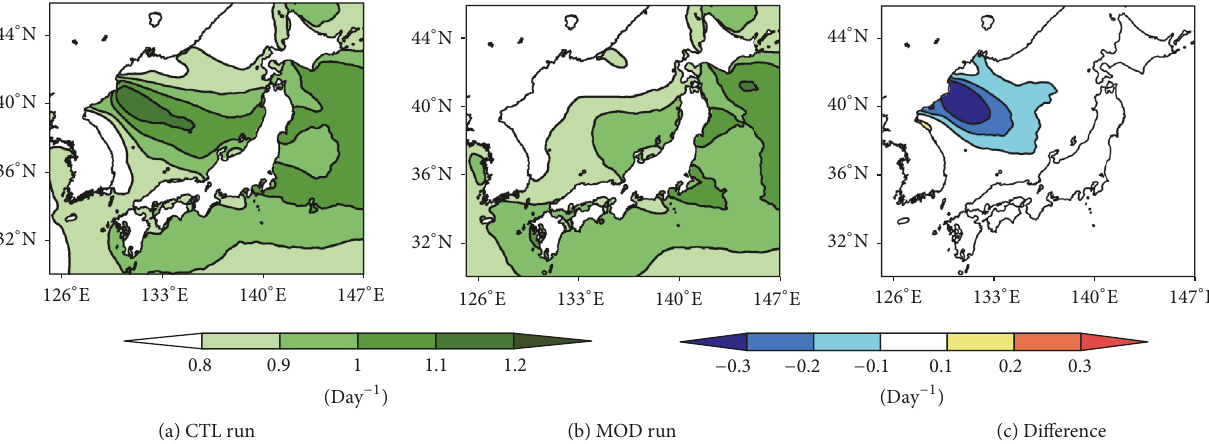
Figure 3: (a) Climatological mean December distribution of the maximum Eady growth rate for the CTL run. The shading interval is 0.1 day −1 . (b) As in Figure 3(a) but for the MOD run. (c) Difference in the maximum Eady growth rate between the MOD and CTL runs (former minus